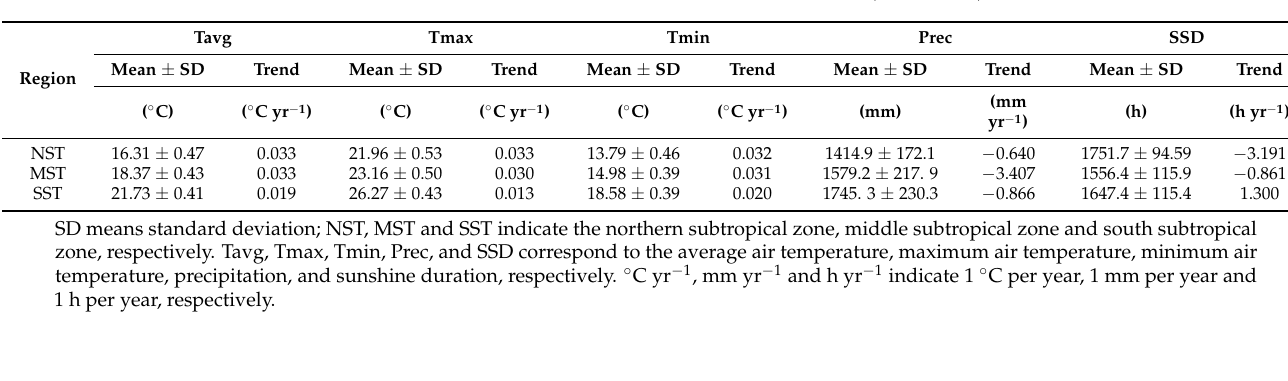
Figure 1. The research area and spatial distribution of climate observation stations. NST, MST and SST indicate the northern subtropical zone, middle subtropical zone and south subtropical zone, respectively. Table 1. Climatic conditions in the three climatic zones (1992 – 2013).